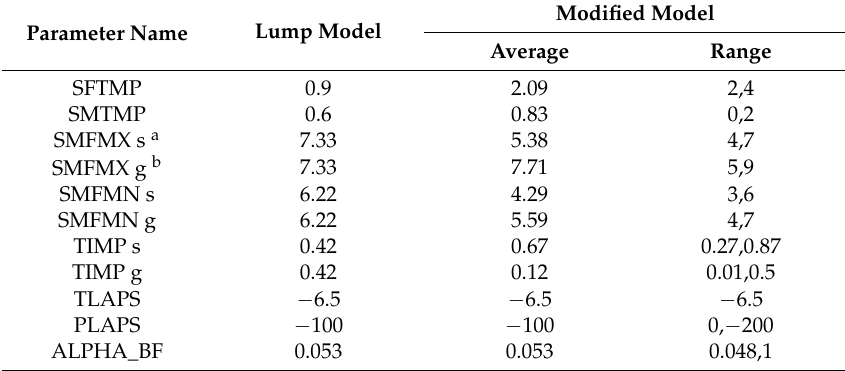
Table 3. Range and mean values of calibration parameters in subbasin-elevation band scale, Narayani River Basin.